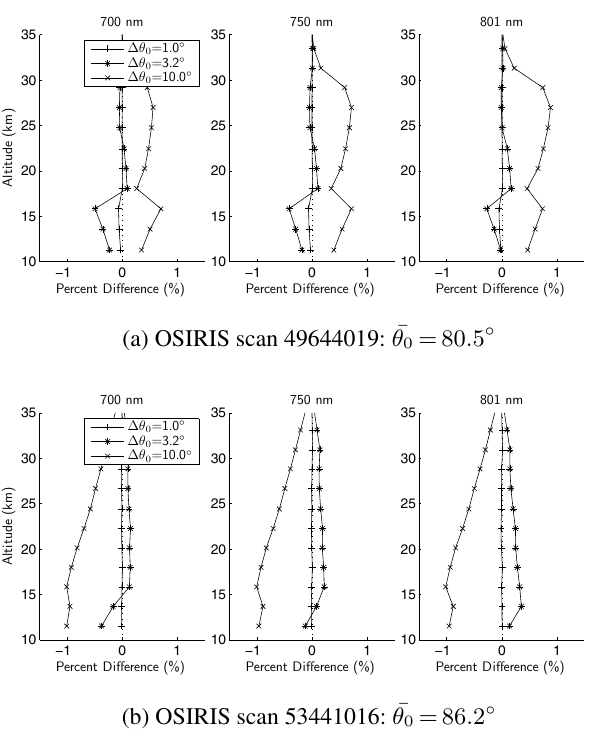
Fig. 5. Percent difference of modeled radiance for increasing coarseness of diffuse profile spacing.